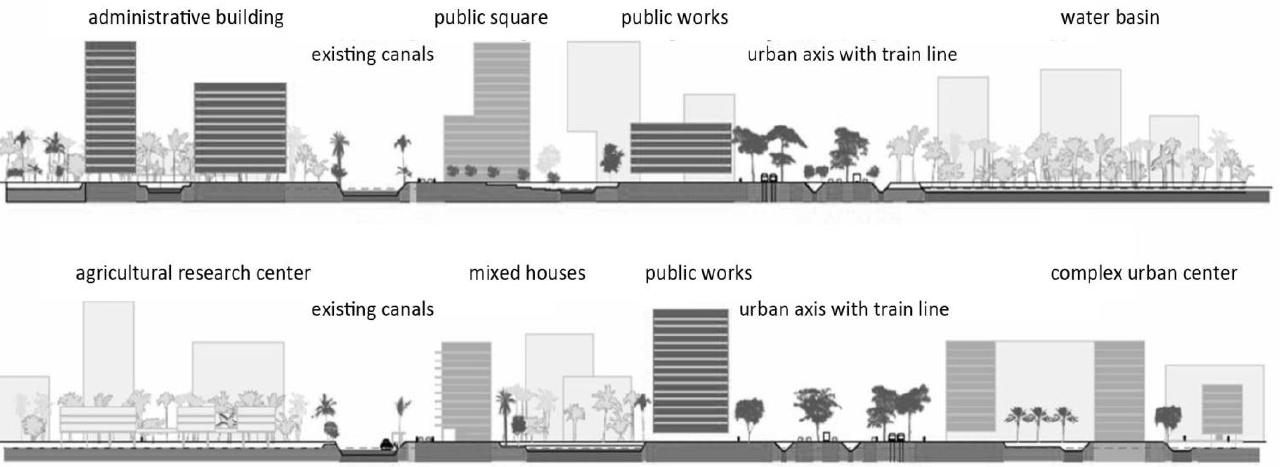
Figure 13. To concretize the design and management manual, the detailed topographic cross-section is an important design tool to guide urbanization and maintain a certain level of balance between excavation and filling. The tiers corresponding to specific activities are proposed, in which green patches are distributed along canals and rivers for flood management and public programs.